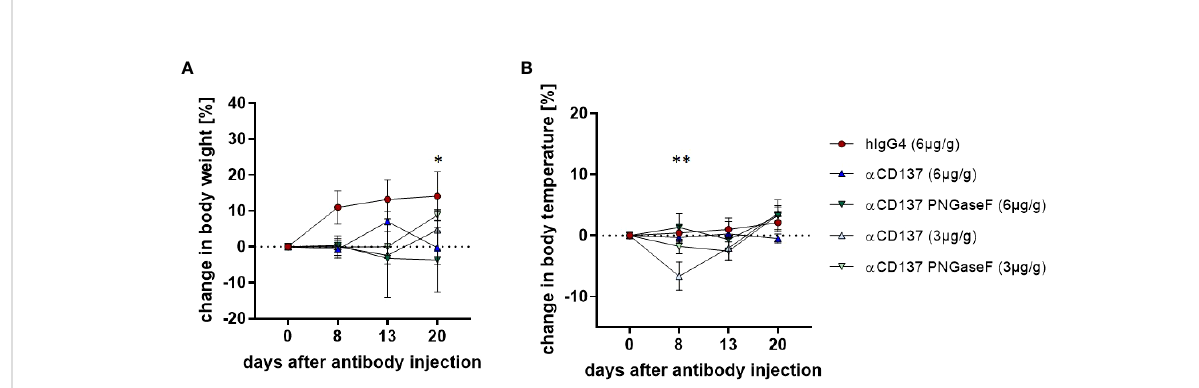
FIGURE 1 Effect of treatment with urelumab antibody variants on body weight and temperature in humanized mice. Shown are relative changes in body weight (A) and body temperature (B) of humanized mice after treatment with a human IgG4 isotype control (6µg/g) or 3µg/g or 6µg/g of urelumab ( a CD137) or a deglycosylated urelumab variant ( a CD137 PNGaseF) until twenty days after antibody injection (hIgG4: n=5, a CD137 6µg: n=7, a CD137 PNGaseF 6µg: n=3, a CD137 3µg: n=3, a CD137 PNGaseF 3µg: n=4). Shown is the mean+/-SEM of one representative out of two independent experiments. For assessment of statistical signi fi cance a Two Way ANOVA with Tukey ’ s multiple comparison test was used. In (A) * indicates p<0.05 for hIgG4 (6µg/g) vs. a CD137 (6µg/g) and hIgG4 (6µg/g) vs. a CD137 PNGaseF (6µg/g). In (B) ** indicates p<0.01 for hIgG4 (6µg/g) vs. a CD137 (3µg/g), a CD137 (6µg/g) vs. a CD137 3(µg/g) and a CD137 PNGaseF (6µg/g) vs. a CD137